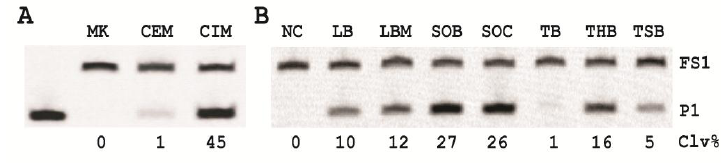
Figure 2. Cleavage reactions of EC1T/FS1 with ( A ) crude extracellular mixture (CEM)-EC and CIM-EC and ( B ) crude intracellular mixture (CIM)-EC collected from E. coli